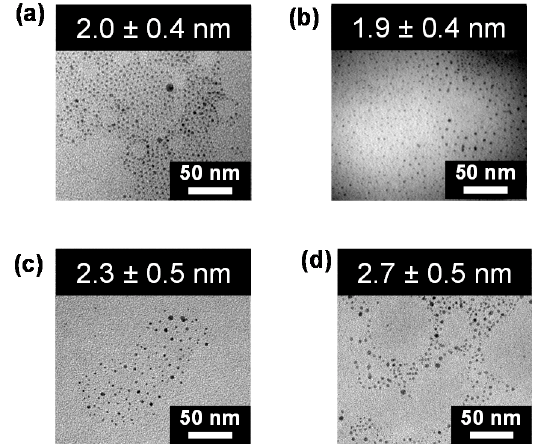
Figure 9. TEM images of the Pt nanoparticles obtained from the reduction of the complex or rotaxane in an aqueous solution (3.0 mM). Measurement was conducted after dropping the solution on the surface of carbon-coated Cu grids. ( a ) [ 3 ](NO 3 ), ( b ) [[ 3 ]( α -CD)](NO 3 ) 3 , ( c ) [[ 3 ]( β -CD)](NO 3 ) 3 , ( d ) [[ 3 ] 2 ( γ -CD)](NO 3 ) 6 .